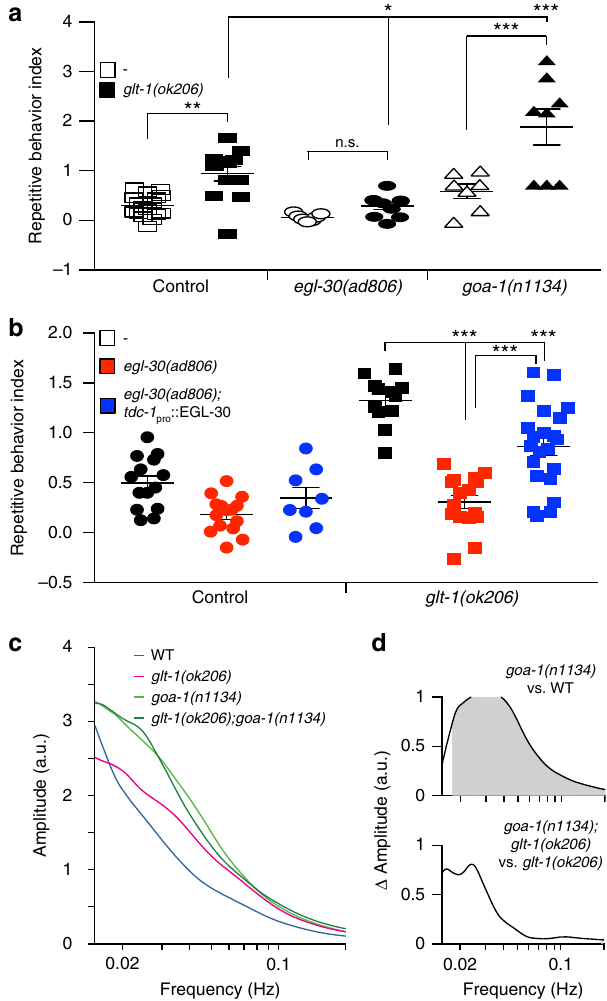
Fig. 6 Glutamate spillover induces repetitive reversals via the egl-30 /G α q signaling pathway. a egl-30 / goa-1 mutations ameliorate/exacerbate repetitive reversals of glt-1 mutants (WT, open boxes, n = 17, glt-1(ok206) , black boxes, n = 12, egl-30(ad806) , open circles, n = 7, glt-1(ok206) ; egl-30 (ad806) , black circles, n = 10, goa-1(n1134) , open triangles, n = 7, glt-1 (ok206) ; goa-1(n1134) , black triangles, n = 8 movies). b EGL-30